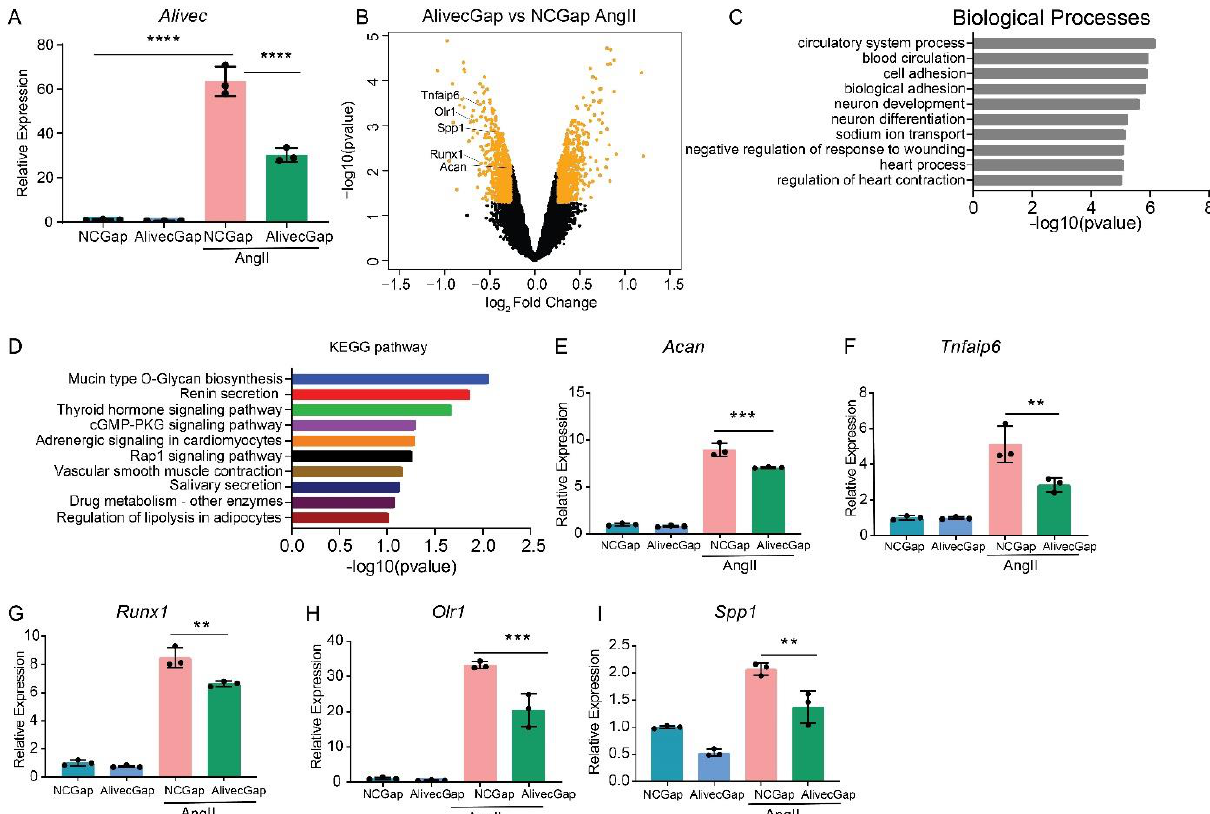
Figure 3. Alivec knockdown attenuates upregulation of AngII-induced chondrogenic genes in RVSMCs. ( A ) Knockdown efficiency of LNA GapmeR targeting Alivec ( Alivec Gap) (100 nM) vs. non-targeting control GapmeR (NCGap) (100 nM), as determined by RT-qPCR. Data presented as mean ± SD, one-way ANOVA followed by Tukey’s post-hoc test and **** p < 0.0001 vs. indicated groups. ( B ) Volcano plot showing differentially expressed genes (orange color) in AngII-treated RVSMCs transfected with Alivec Gap vs. NCGap. Labeled dots indicate genes involved in chondrogenesis. ( C ) Gene ontology (GO) analysis by the TOPPGENE tool of differentially-expressed (DE) genes showing the top 10 biological processes enriched in downregulated genes after Alivec knockdown. ( D ) KEGG pathway analysis of differentially-expressed (DE) genes, showing the top 10 molecular pathways affected in downregulated genes after Alivec knockdown. ( E – I ) RT-qPCR validation of indicated chondrogenic genes after Alivec knockdown in RVSMCs treated ± AngII (100 nM, 3 h). Data presented as mean ± SD, one-way ANOVA followed by Tukey’s post-hoc test and ** p < 0.01 and *** p < 0.001 vs. indicated groups) n = 3 biological